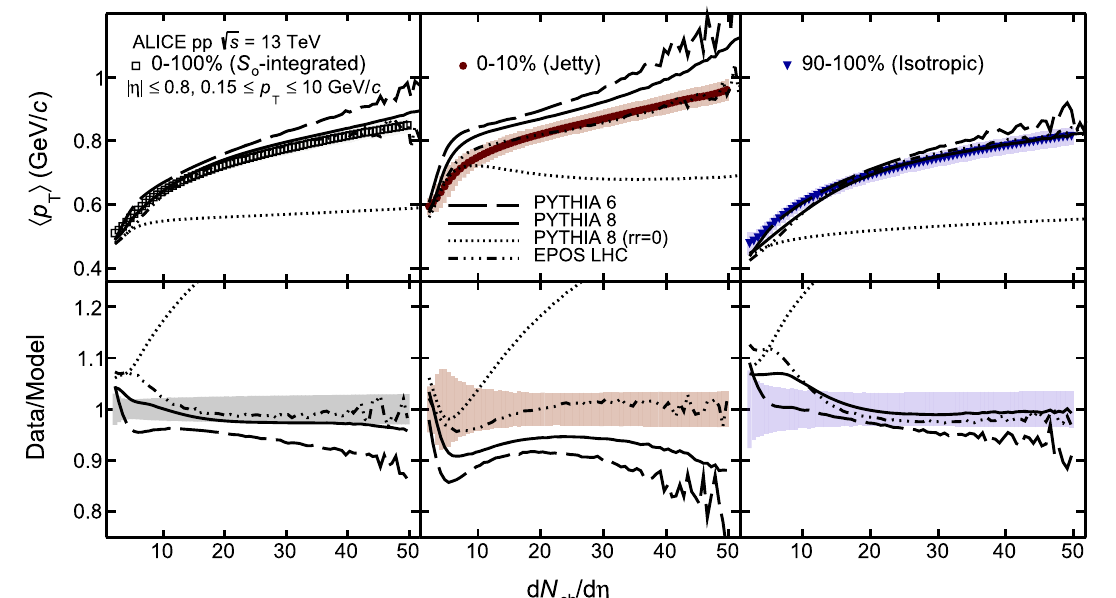
Fig. 8 Average transverse momentum as a function of event multi- colorreconnection,aswellasPYTHIA6andEPOSLHCaredisplayed. √ s = 13TeV. Results for the spherocity- Statistical uncertainties (error bars) are negligible compared to system- plicity in pp collisions at atic uncertainties (shaded area around the data points). Data to model integrated case (0–100%), the most jet-like (0–10%) and isotropic ratios are shown in the bottom panel. The color band around unity rep- (90–100%) events are compared with Monte Carlo predictions. Predic- resents the systematic tions of PYTHIA 8 with and without (null reconnection range, rr = 0)